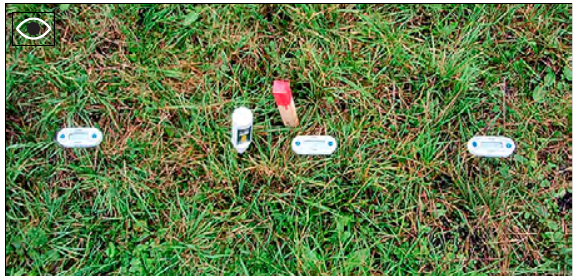
Figure 2. Semi-stationary soil temperature measurement in Olomouc and